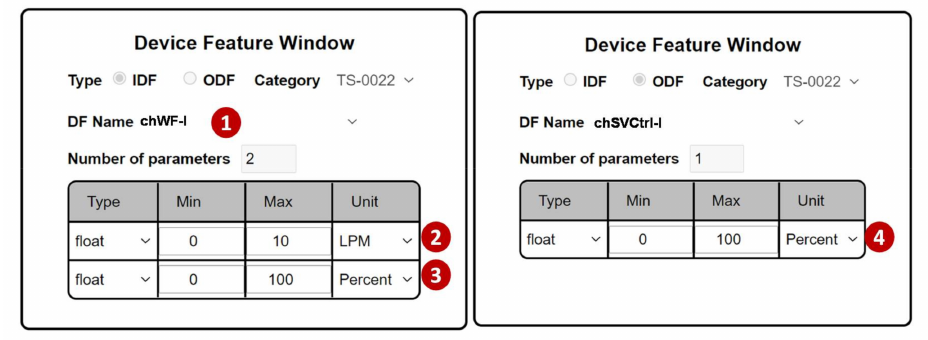
Figure 14. The IDF and the ODF for the water-cooled